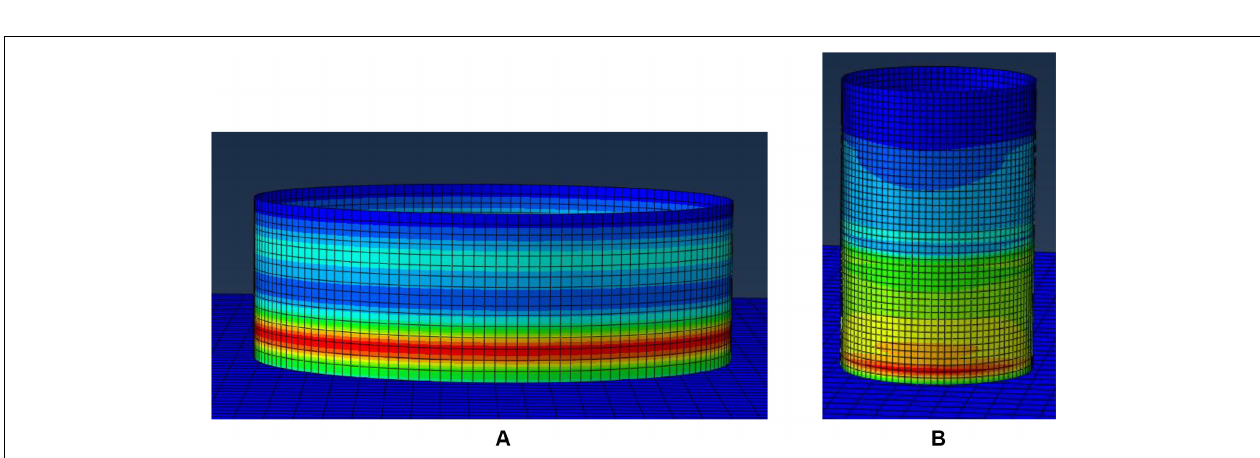
FIGURE 3 | Illustrative height-wise distribution of von Mises stresses for (A) the squat tank and (B) the slender tank.